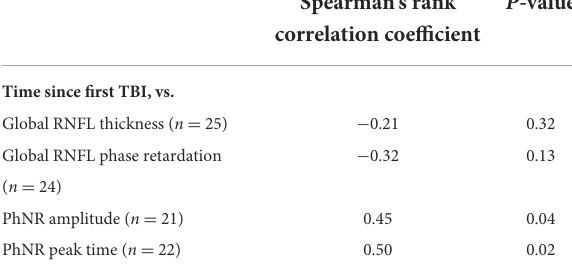
TABLE 8 Associations between time since first traumatic brain injury (TBI) and retinal nerve fiber layer (RNFL) structural parameters and electroretinography functional parameters in case